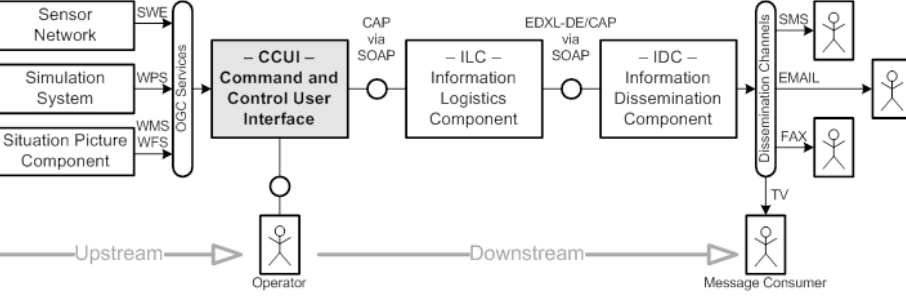
Fig. 3. Upstream, decide-and-act, and downstream segments unfolded and mapped to system components (Lendholt and Hammitzsch, 2011). Table 1. Summary of data refinement levels for GITEWS sensors. Data volumes decrease from raw data (bottom) to aggregated data (top) suited for complex decision processes in warning